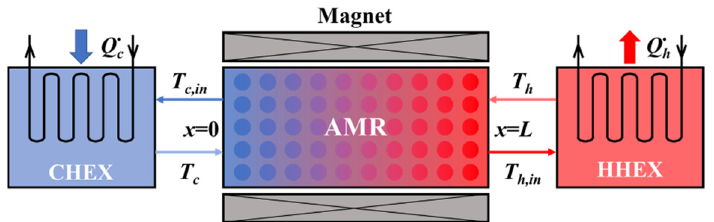
Figure 2. Schematic diagram of the numerical model.